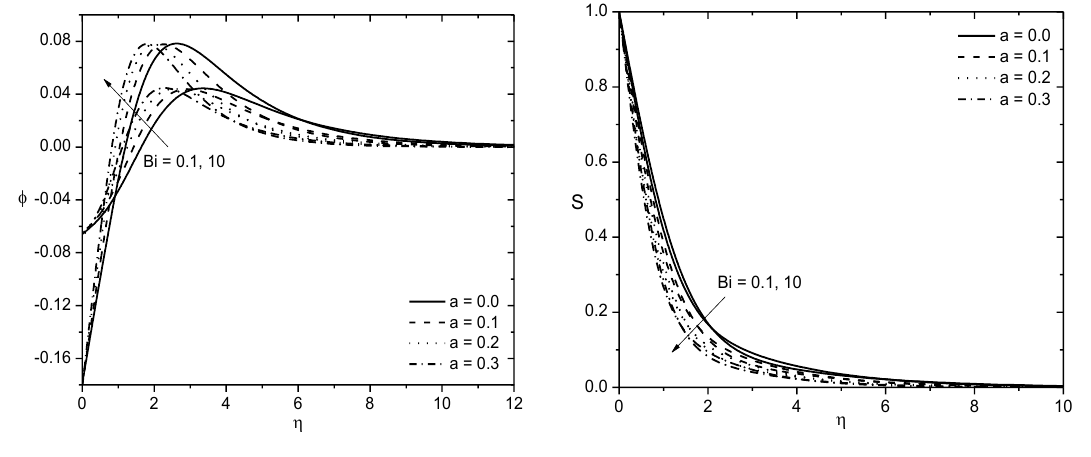
Figure 8. Effects of Bi and a on the solid volume fraction